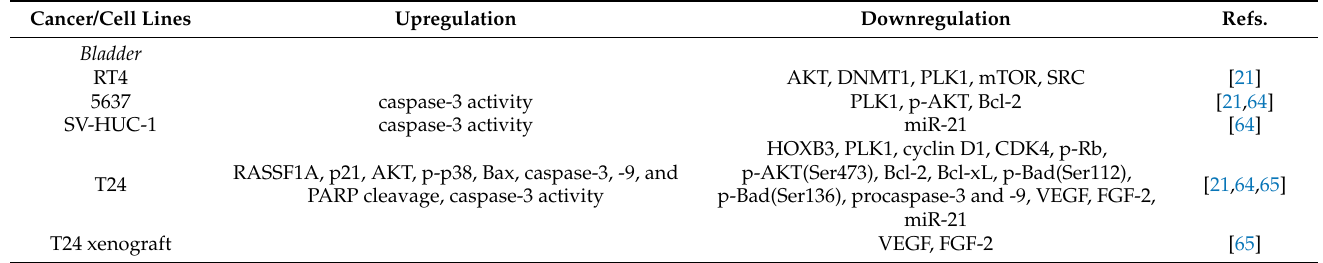
Table 1. Molecular targets of resveratrol-induced